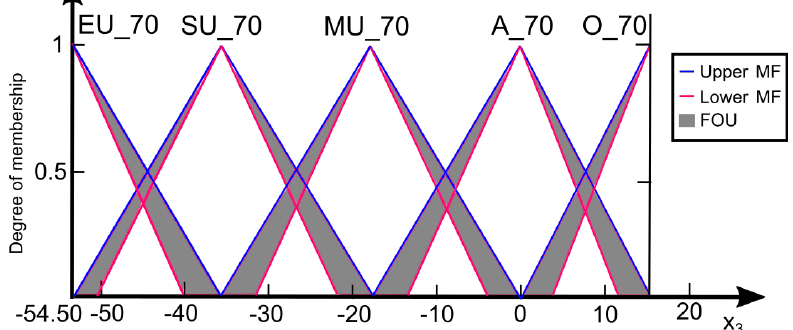
Figure 7. Input variable Average assessment of speed 70 km/h. Used notation: MF—membership function; FOU—footprint of uncertainty.